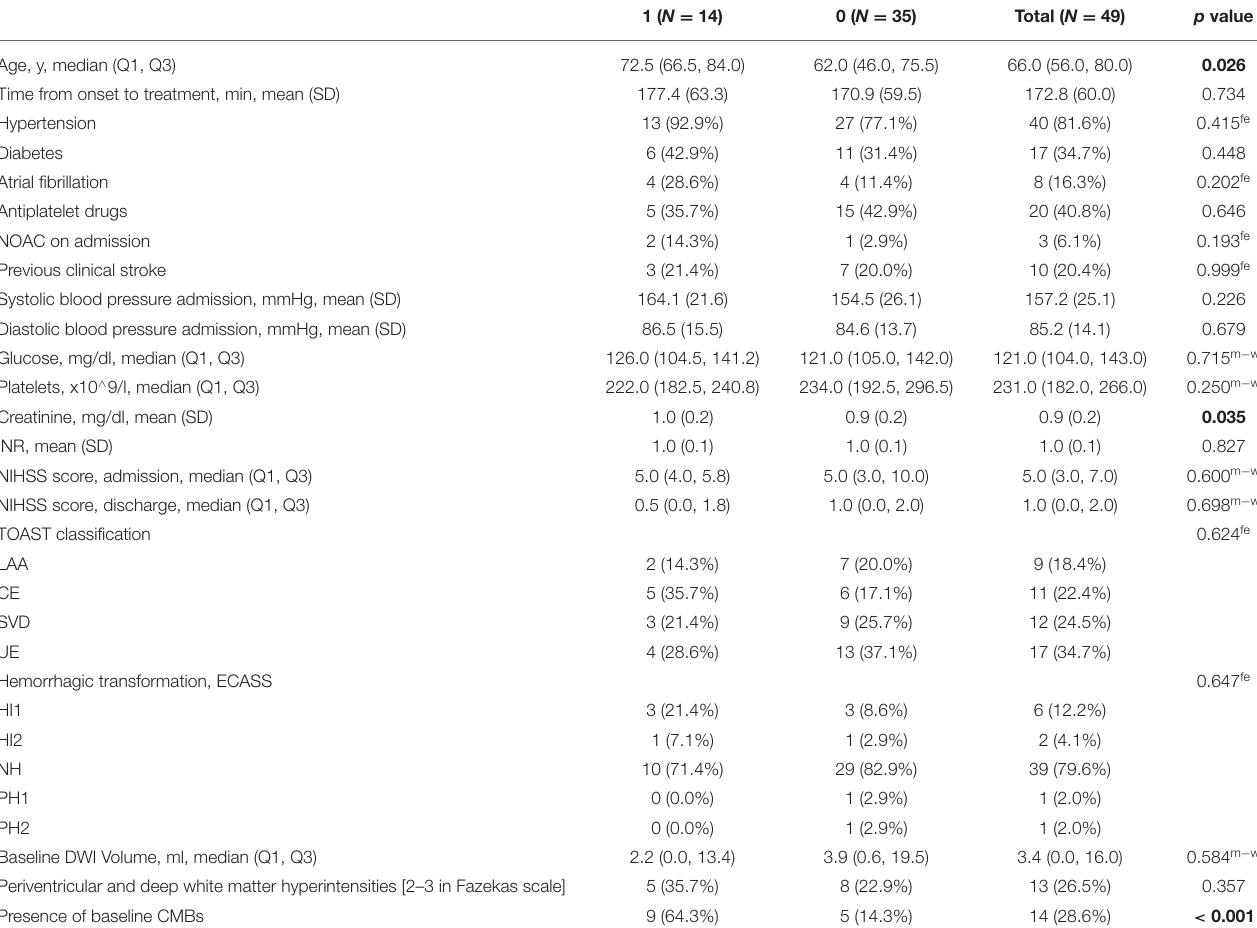
TABLE 3 | Characteristics of two groups – with ( N = 14) and without ( N = 35) new CMBs.